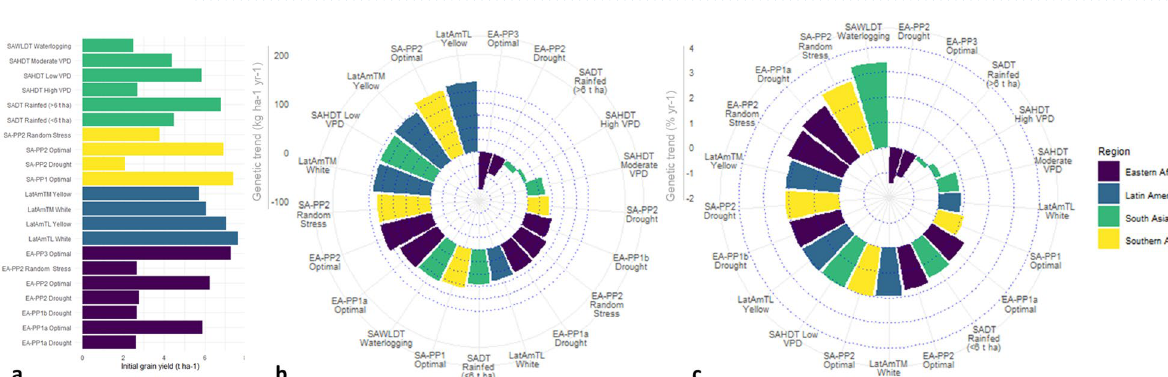
Figure 4. ( a ) Average grain yield in each of the breeding pipelines by individual management practices in the first year; genetic trend across product profiles presented in ( b ) kg ha −1 yr −1 and ( c ) % yr −1 . Non-significant trends are not presented. Abbreviations: Drt, drought; HYP, high yield potential; LYP, low yield potential; Med, medium; Opt, optimum; RS, random stress; VPD, vapour pressure deficit; W, white; Y,